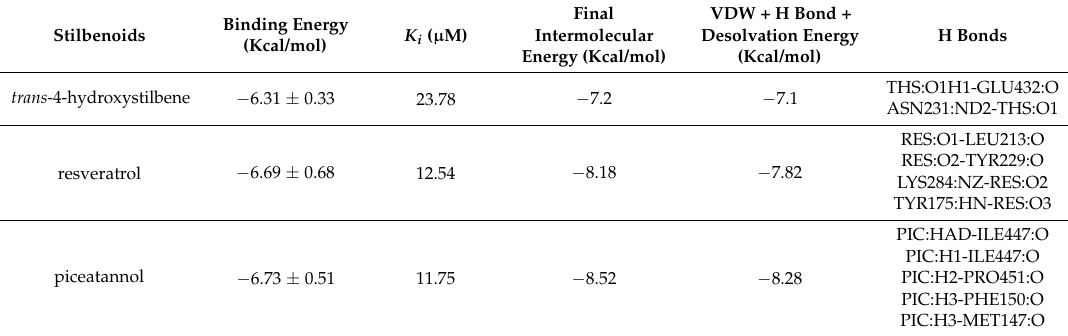
Table 1. Binding Energy of trans -4-hydroxystilbene (THS), resveratrol (RES), and piceatannol (PIC) and Akt protein docking